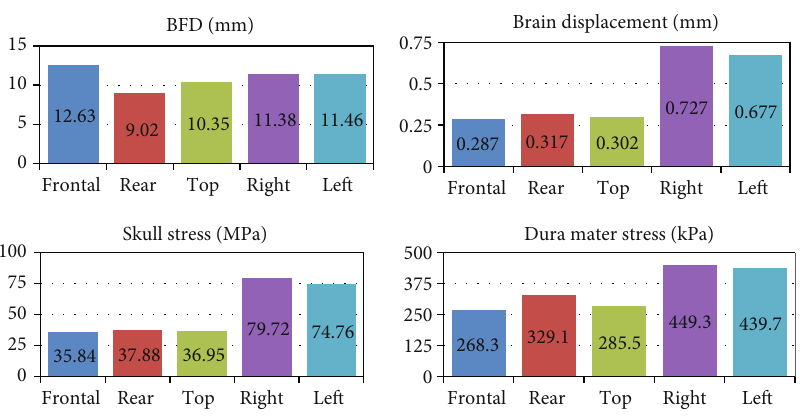
Figure 11: Comparison of peak brain damage in di ff erent directions.